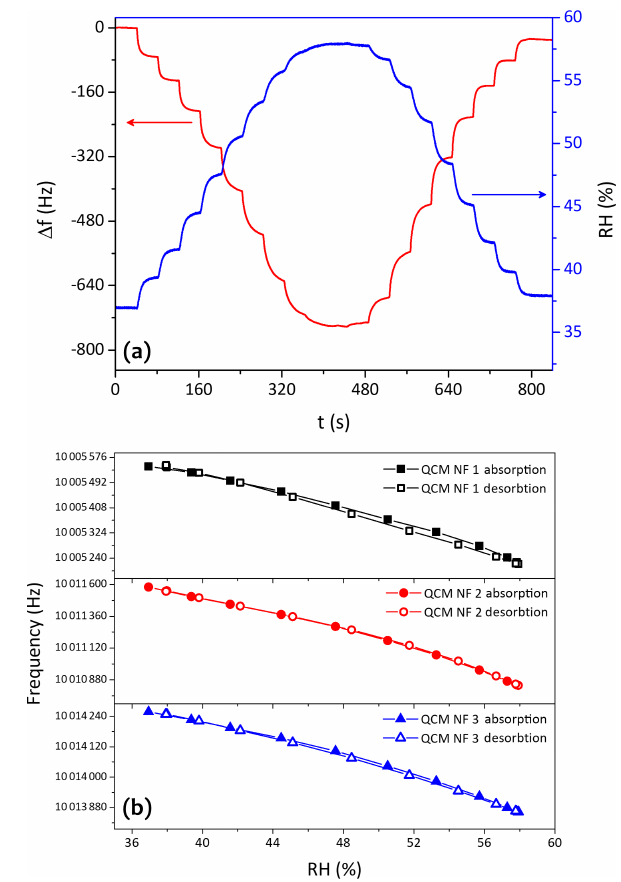
Figure 7. (a) PEDOT–PSS/PVA nanofiber QCM NF 2 humidity sensor (cid:49)f during the increase and decrease in humidity level and (b) hysteresis profile.